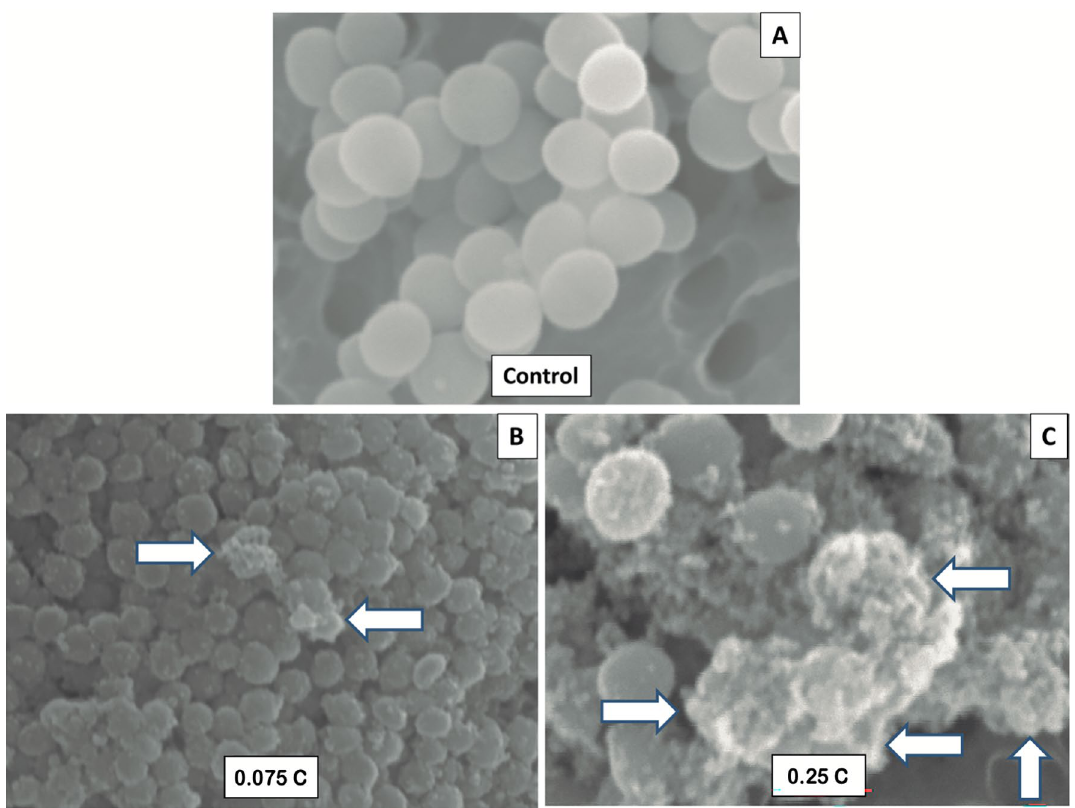
Figure 6. Bacterial cells morphology observed with scanning electron microscopic evaluation. ( A) Control group with normal morphology (round cells with bright surface and without any apparent cell lysis) (10,000×). ( B) Biofilm sample treated with 0.075 C, with abnormal morphology (flattened and shrunken cells with rough surface and with some lysed cells marked with white arrows) (8000×). ( C) Biofilm sample treated with 0.25 C, with more abnormal bacterial cell morphology (flattened and shrunken cells with rough surface and more lysed cells marked with white arrows)